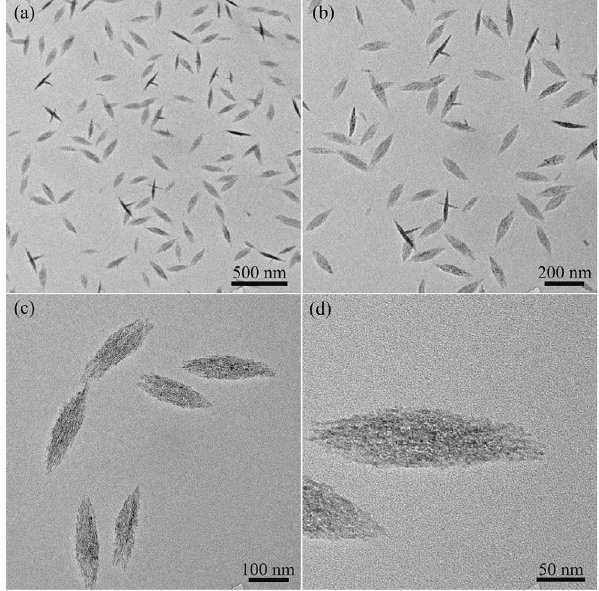
Fig. 3 TEM images with different magnification of the as- prepared spindle shape CuO nanostructure obtained by reaction temperature of 50 °C and reaction time of 8 h: (a)